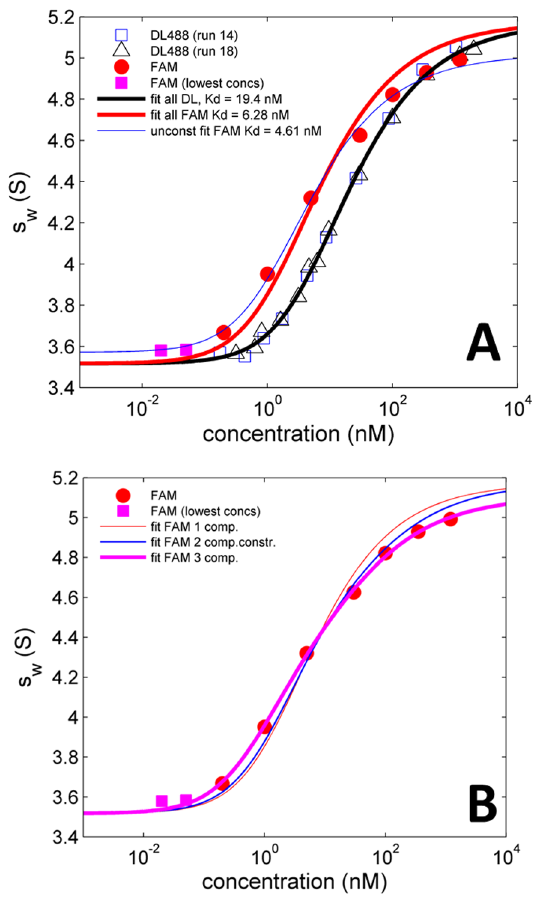
Figure 5. Comparison of the s w isotherm of Dylight488-GluA2 ATD with that of FAM-GluA2 ATD. (A) Dilution series of Dylight488- GluA2 ATD (open squares and triangles show data from two different runs) with a global best-fit single component, single class of sites model (bold black line) which leads to estimates of K D =19.4 nM, s 1 =3.52 S, and s 2 =5.17 S, with a rmsd of 0.021 S. A dilution series of FAM-GluA2 ATD with a labeling ratio 1.32 is shown in solid red circles, extended to lower concentrations as shown with bold magenta squares. A single- component, single-site fit to the entire FAM-GluA2 ATD data, constrained to the s -values derived from the Dylight488-GluA2 ATD analysis, is shown as red solid line, leading to a best-fit K D –value of 6.3 nM and rmsd of 0.077 S. For comparison, a single-component fit to the FAM-GluA2 ATD data excluding the two lowest concentrations (i.e. a fit to the red circles only) and freely adjusting the s -values, is shown as thin blue line, resulting in a K D estimate of 4.6 nM and apparent s 1 - and s 1 - values of 3.58 S and 5.02 S, respectively, with an rmsd of 0.023 S. (B) The same FAM data as in Panel A, modeled with different numbers of components, each exhibiting a different class of sites, and each constrained to have the same monomer and dimer s -value as derived from the single-component fit to Dylight488-GluA2 ATD shown in Panel A. (1) For comparison, the single component fit from Panel A (thin red line, rmsd = 0.077S); (2) A two-component model (thin blue line) with